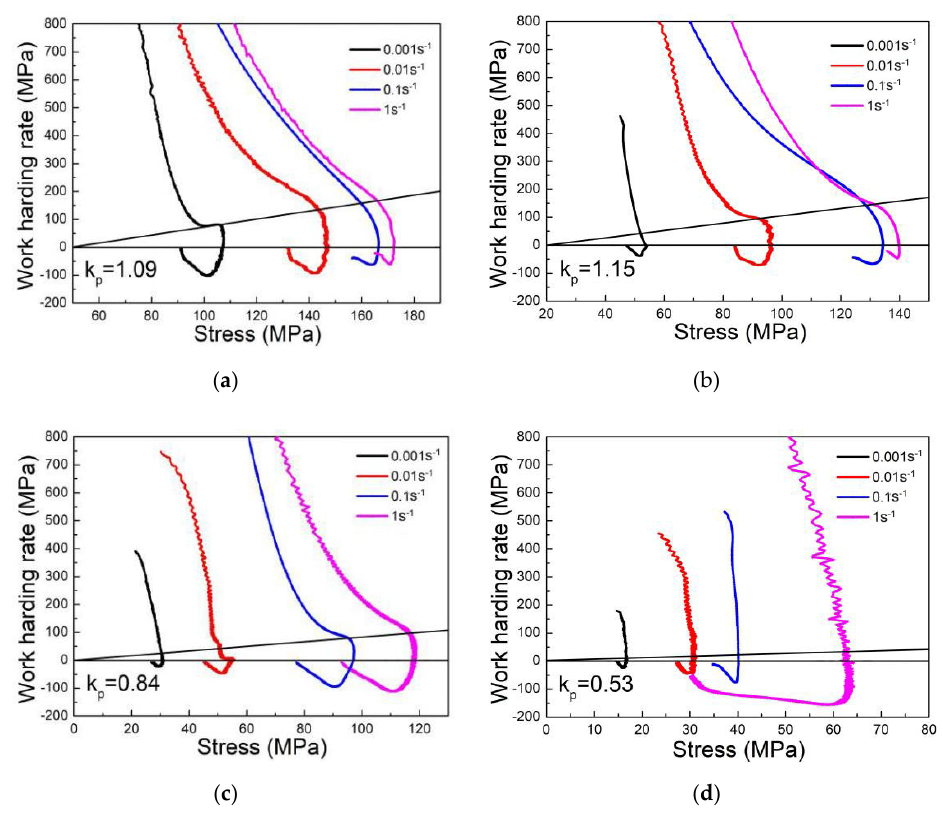
Figure 10. Variation of the work-hardening rate θ with flow stress σ for MZC at different temperatures: ( a ) 523 K; ( b ) 573 K; ( c ) 623 K and ( d ) 673 K.